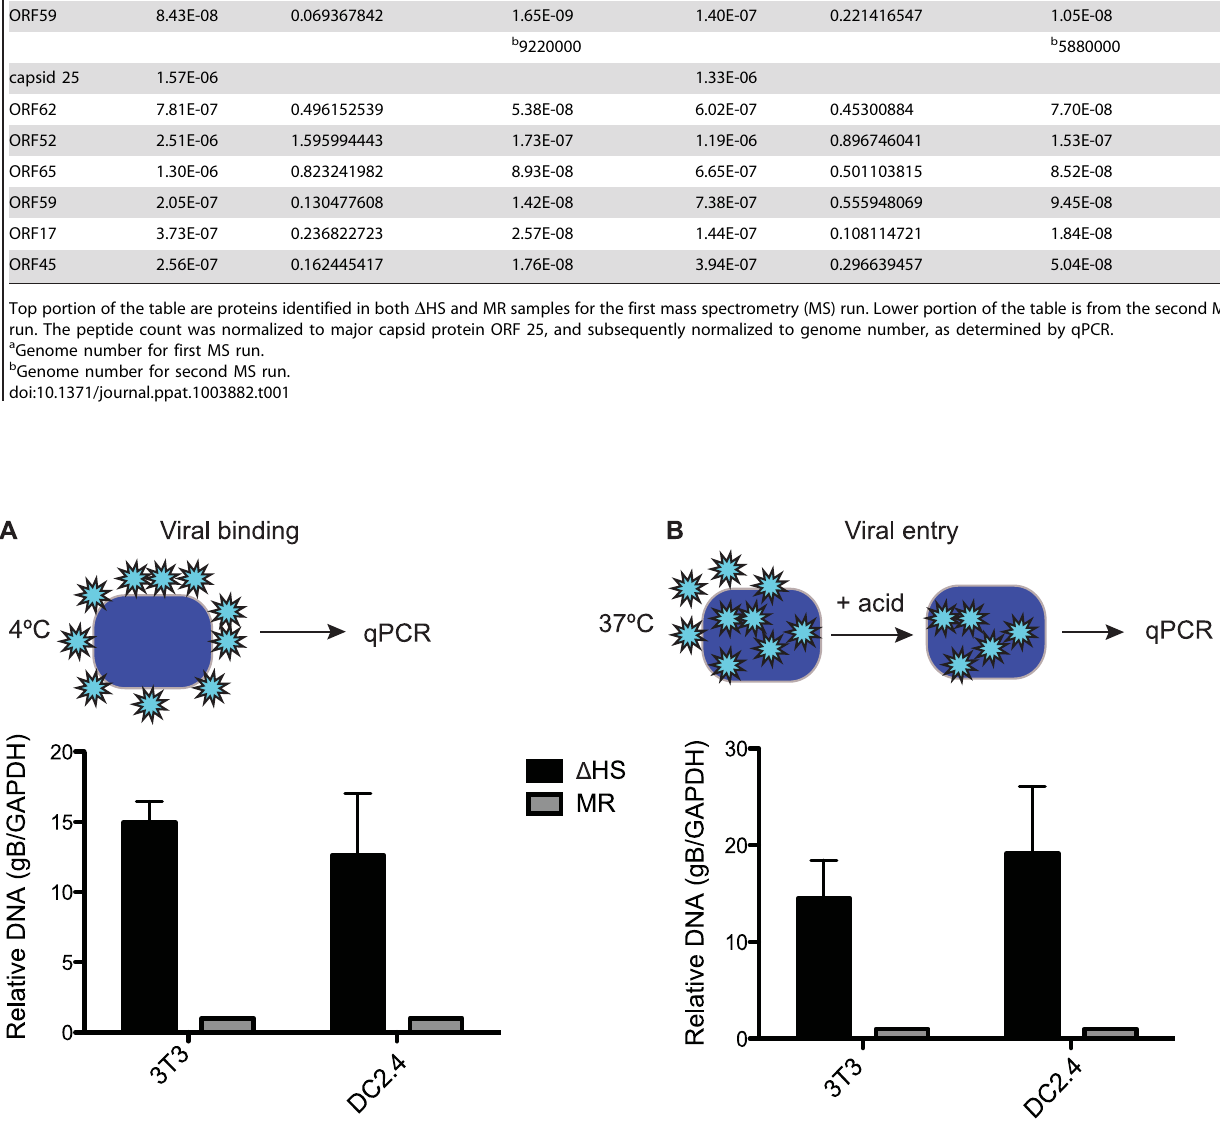
Figure 4. Altered virion composition leads to enhanced cell surface binding and entry. (A) Schematic showing cells were infected at an MOI of 5 at 4 u C to allow viral binding, but prevent uptake. Both NIH 3T3 cells and DC2.4 cells were infected with MR or D HS MHV68. Cells were washed 4X with PBS at 90 min post infection, DNA was isolated, and qPCR used to quantify relative DNA levels by normalizing gB to GAPDH levels and setting MR levels to 1. (B) Cells were infected at an MOI of 5 at 37 u C to allow uptake of virions. At 90 min post infection, the viral particles not internalized were stripped from the surface by the addition of 40 mM citric acid for 5 minutes and washed 4X with PBS. DNA was isolated and qPCR used to quantify relative DNA levels of internalized virus. Each graph represents 3 independent